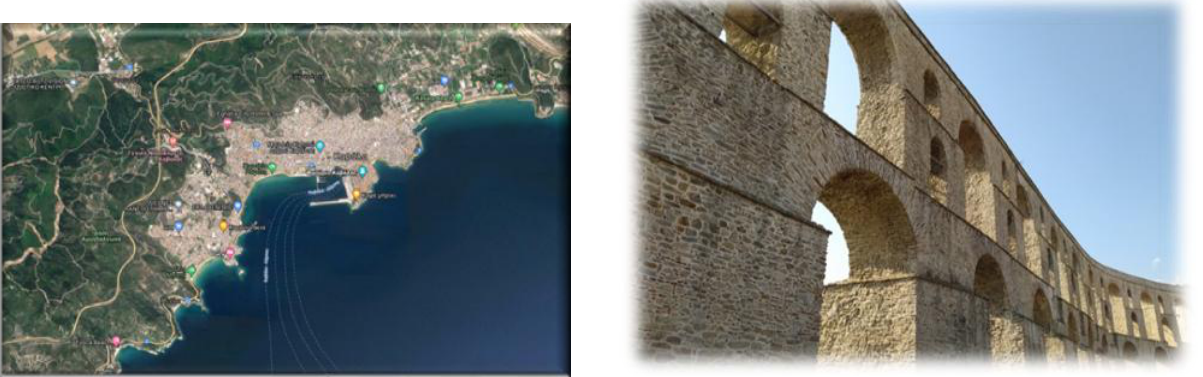
Figure 1 . The Region of Municipality of Kavala